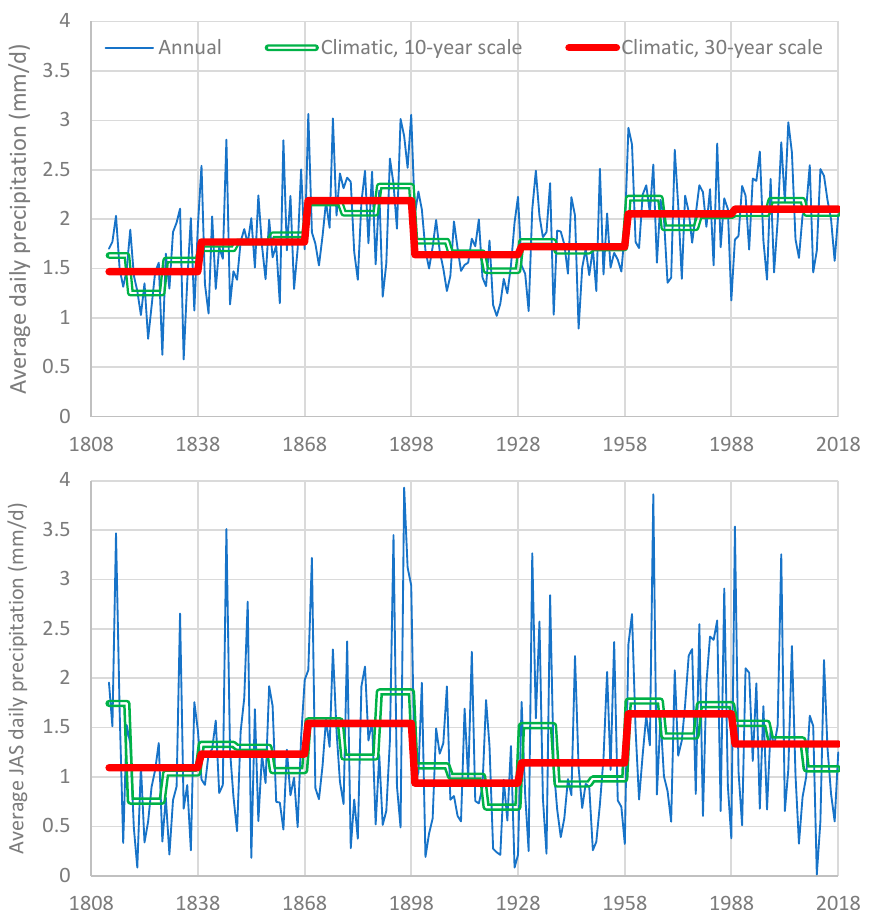
Figure 4. ( upper ) Evolution of average daily precipitation in Bologna, as a climatic element, seen at the annual and the climatic time scales of 10 and 30 years; ( lower ) as in upper panel but for a time window of the three summer months, JAS.